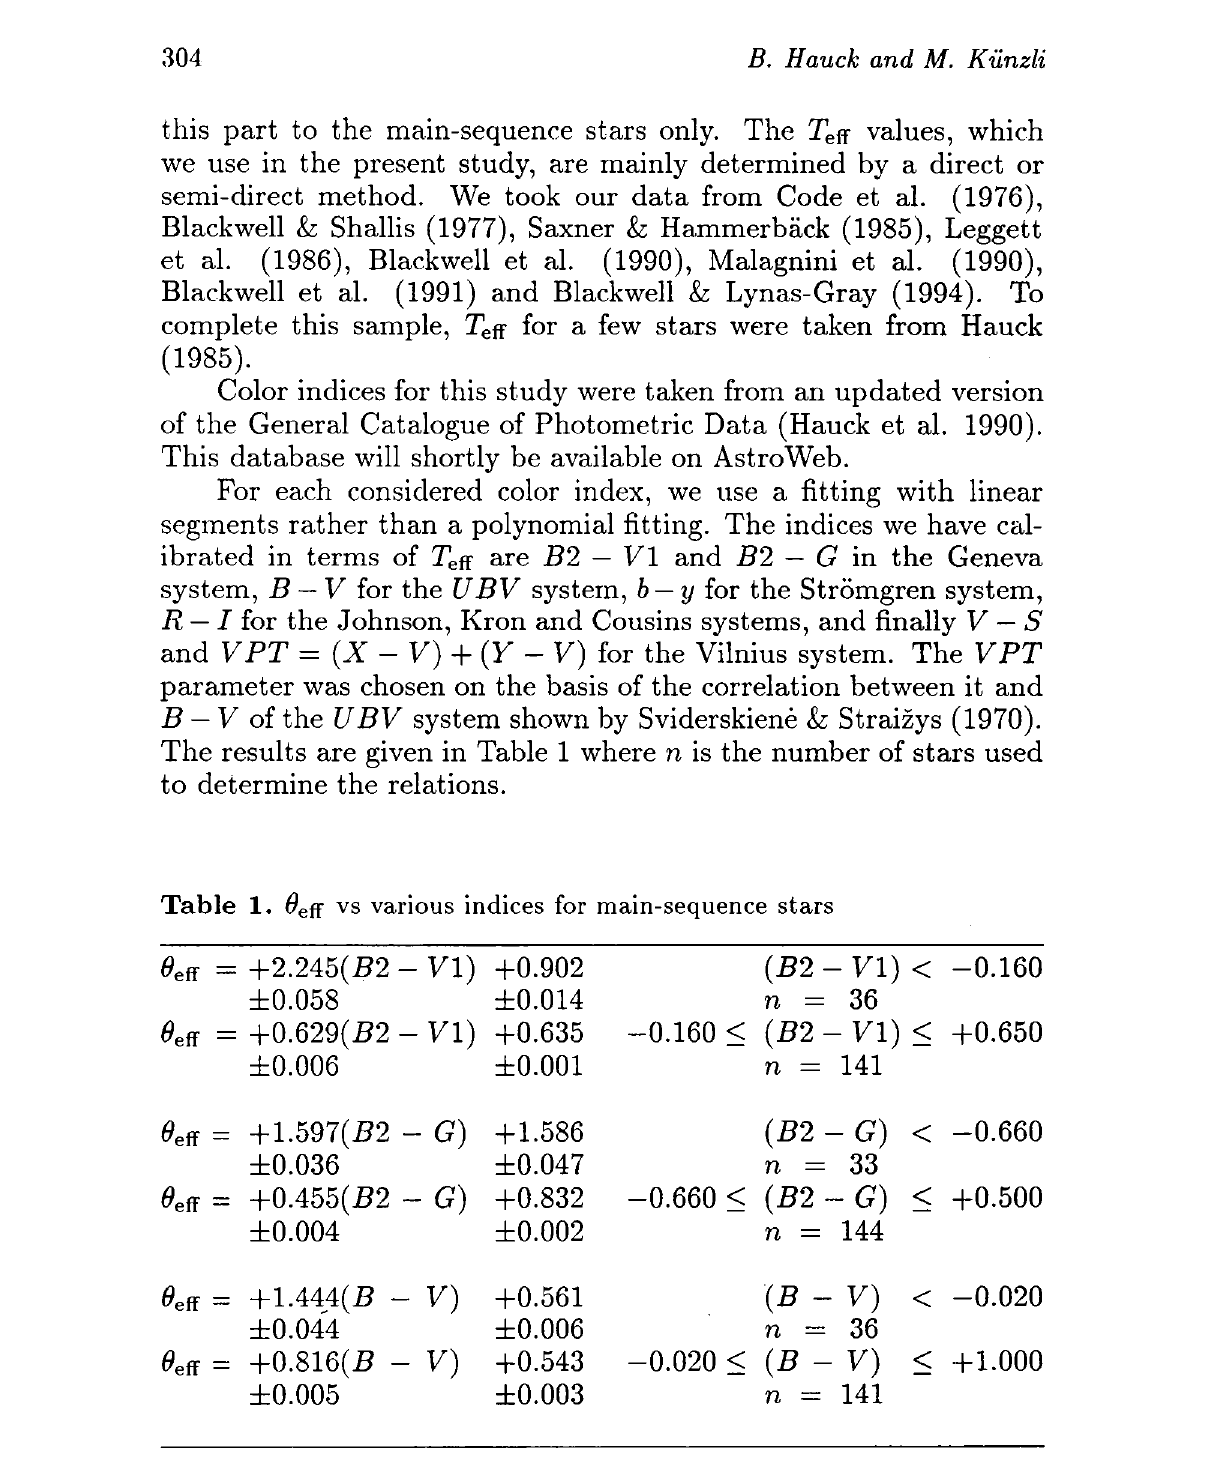
Table 1. 0 ff vs various indices for main-sequence stars e 0 = +2.245(52 - eff